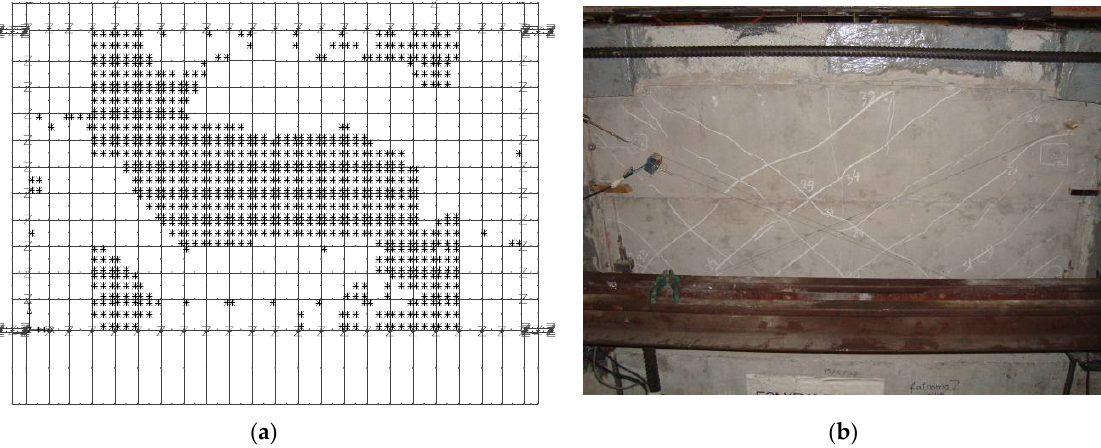
Figure 27. ( a ) The numerically predicted diagonal tension limit state for specimen RC ‐ IP 3. ( b ) The observed damage for specimen RC ‐ IP 3.